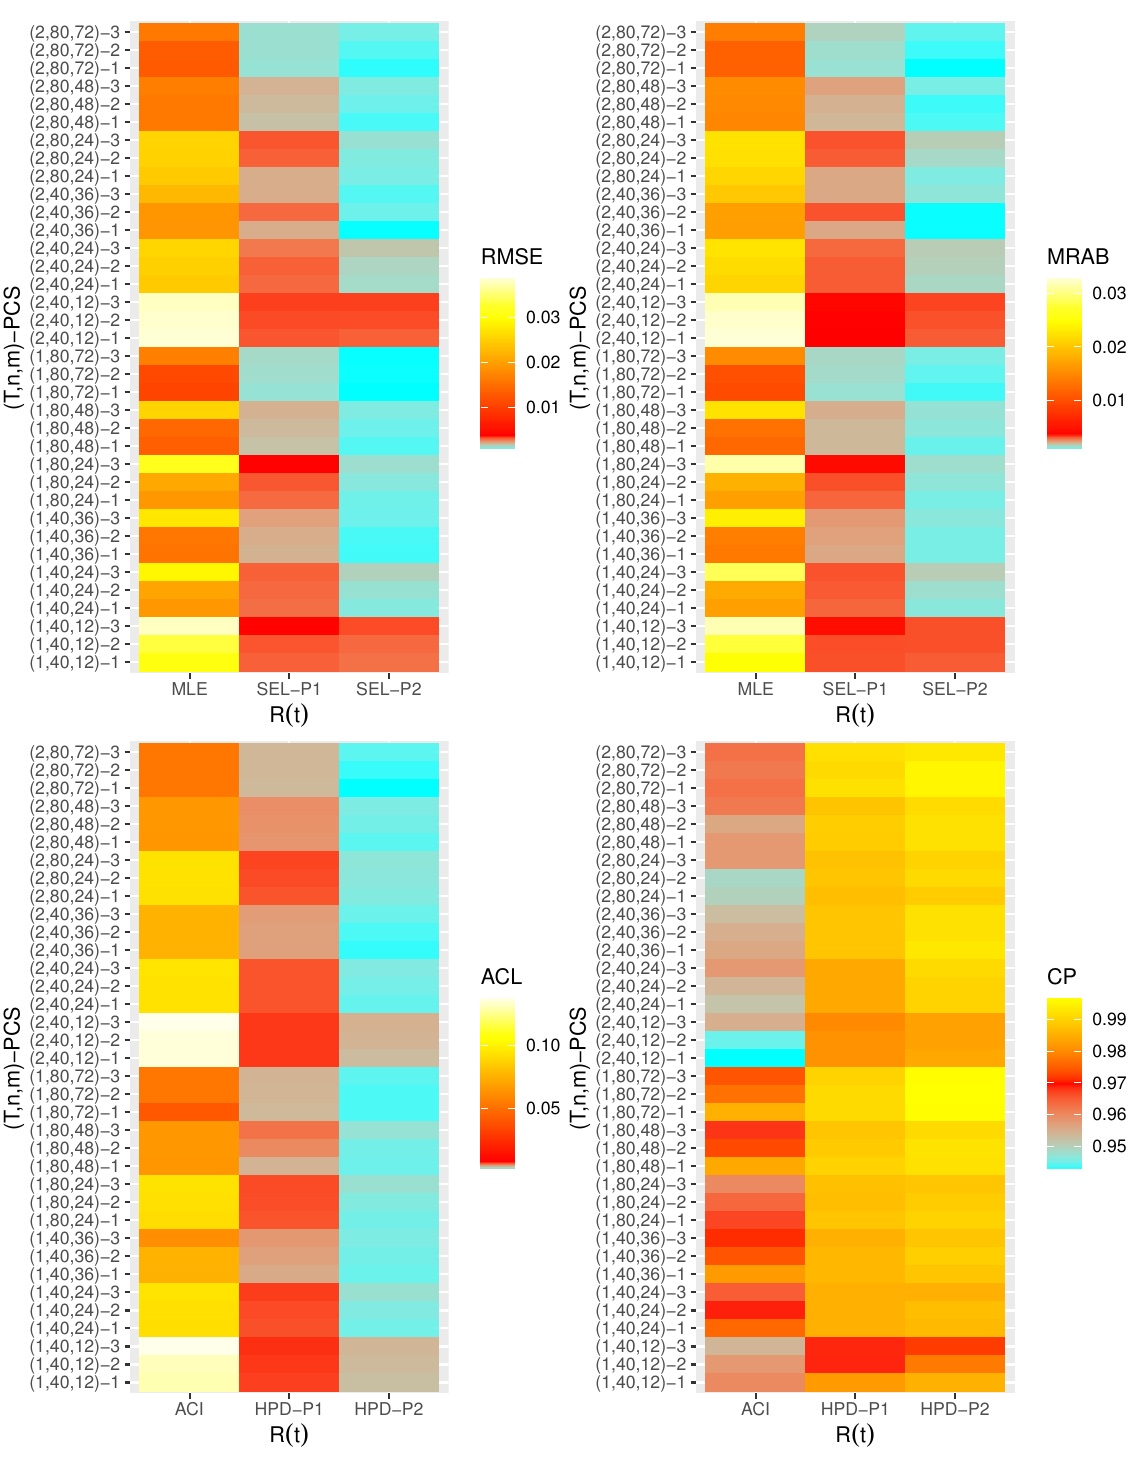
Figure 5. The heatmaps for the estimation results of R ( t ) when λ =